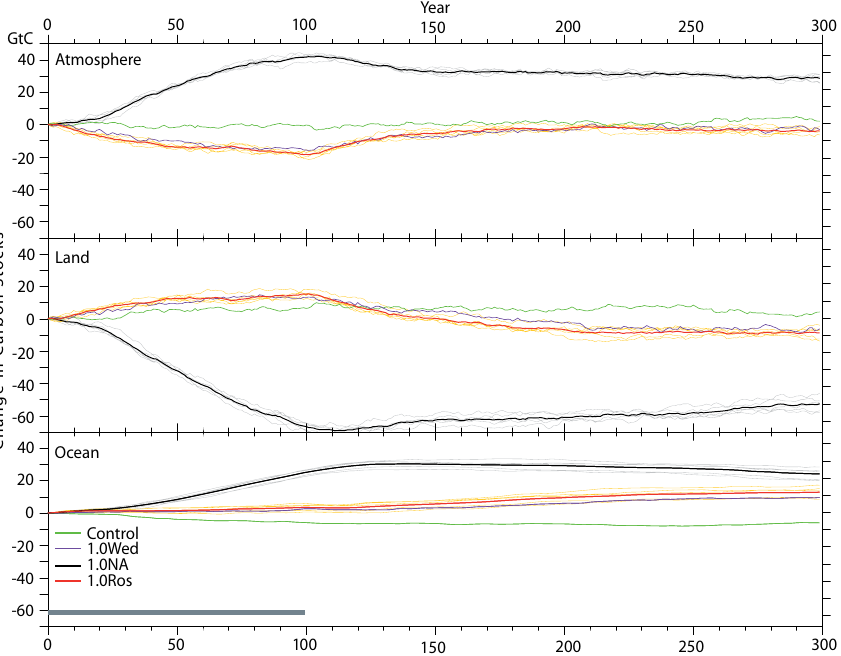
Fig. 3. Responses to freshwater perturbations of different carbon inventories: atmosphere (top), land (middle), and ocean (bottom). The values are the anomalies with respect to the 100-year average of the Control and given in GtC. Values are 10-year box averages. The two perturbations of 1.0NA (black) and 1.0Ros (red) are given as the averages of five ensemble members and the grey and orange curves in the background are the five individual runs in each ensemble. The grey bar at the bottom marks the duration of the freshwater